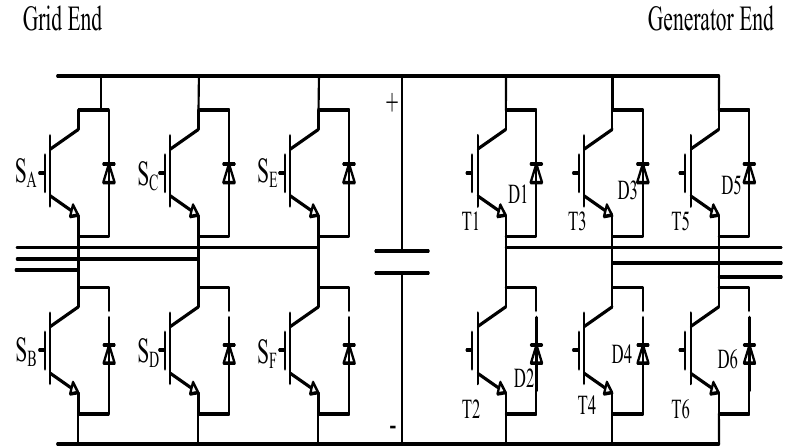
Figure 10. Representative diagram of a 2-level back-to-back voltage source converter